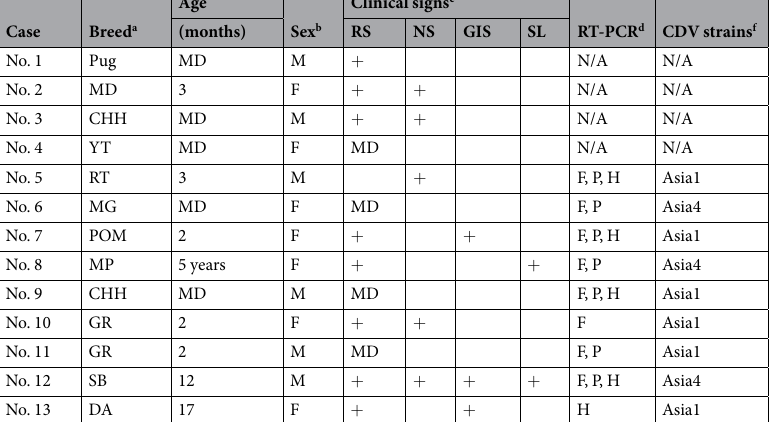
Results Pathologic findings.